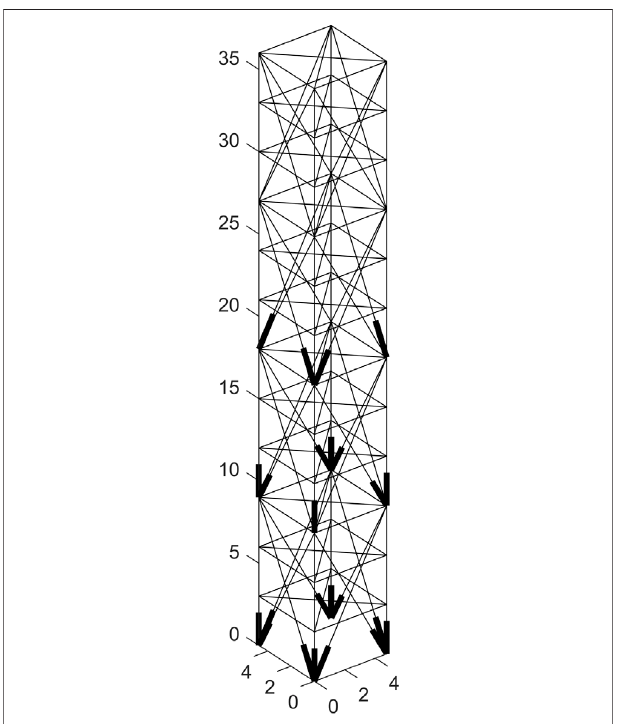
FIGURE 4 | D1244 Actuator placement. A bold line at the bottom end indicates an active element. The actuator layout allows for an equally good adaptation for all loading directions (Source: